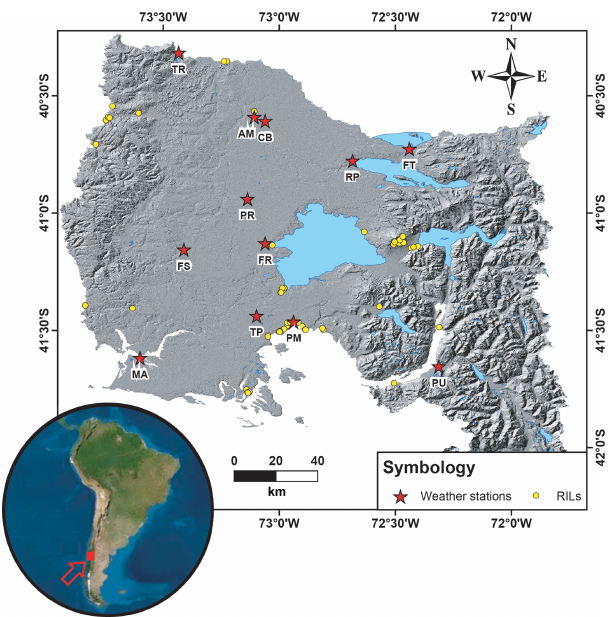
Figure 1. Study area in the southern Andes zone and the northern part of the Patagonian Andes. RIL events in the area are highlighted with yellow dots, and red stars mark the meteorological stations available. Hillshade based on Shuttle Radar Topography Mission (SRTM)